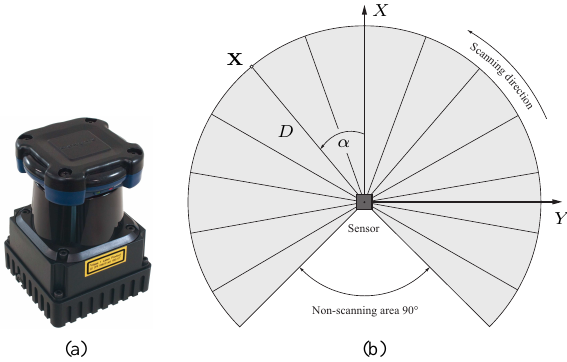
Figure 1: (a) Laser scanning range finder Hokuyo UTM-30LX- EW (Hokuyo, 2014). (b) Measuring principle and coordinate sys- tem